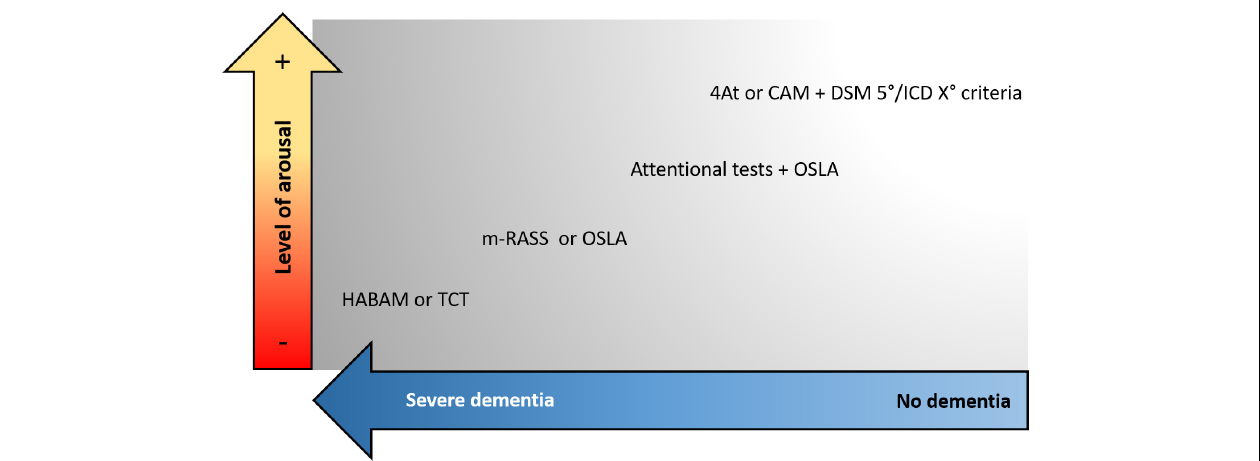
FIGURE 2 | Proposed approach to select the screening tools for delirium according to the presence of dementia and the patient’s level of arousal. CAM, Confusion Assessment Method; DSM, Diagnostic and Statistical Manual of Mental Disorders; ICD, International Classification of Diseases; OSLA, Observational Scale of Level of Arousal; m-RASS, modified Richmond Agitation and Sedation Scale; HABAM, hierarchical assessment of balance and mobility; TCT, Trunk Control